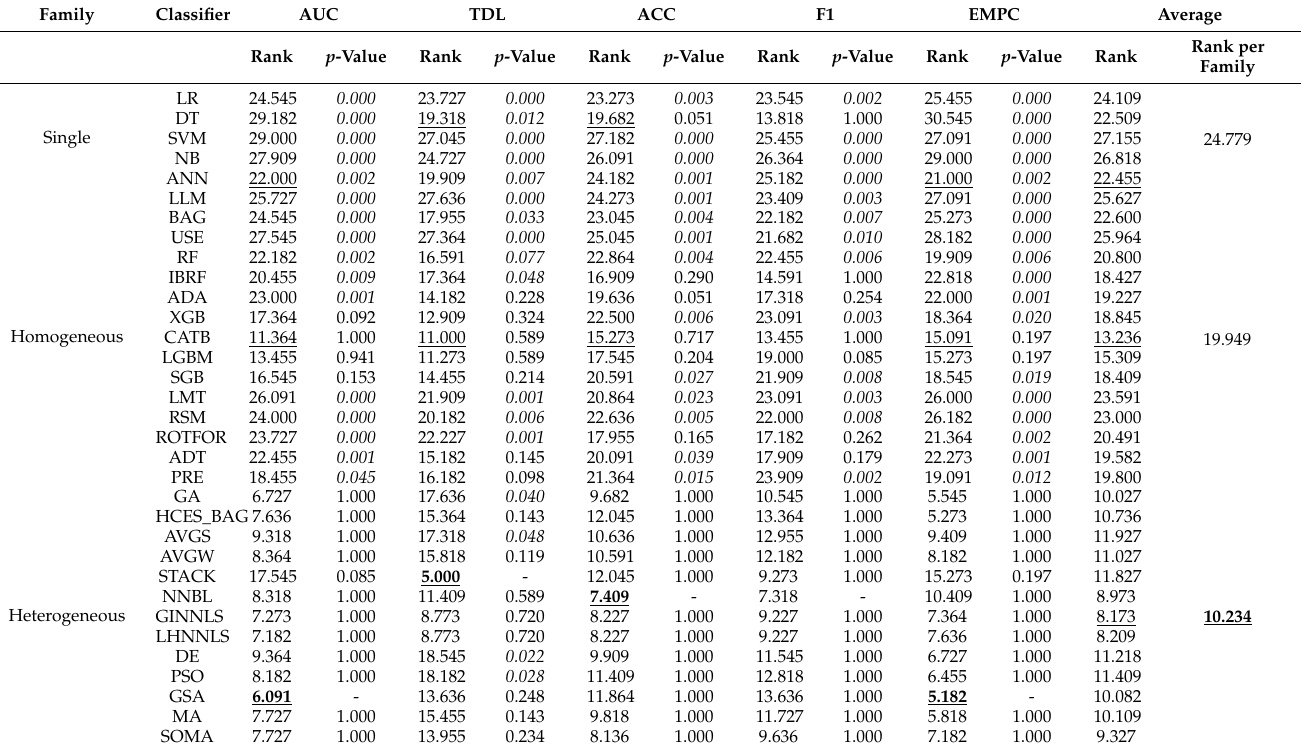
Table 6. Average classifier ranks across 11 data sets and pairwise Friedman test with Rom’s procedure for each performance measure. Lower ranks indicate a better performance across data sets. The best methods per family are underlined and the overall best methods are in bold underlined. p -values smaller than 0.05 are indicated in